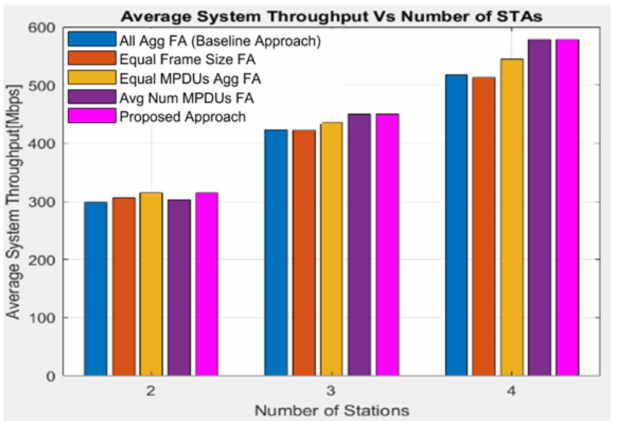
Figure 5. Performance of average system throughput as the number of STAs varies from 2 to 4.